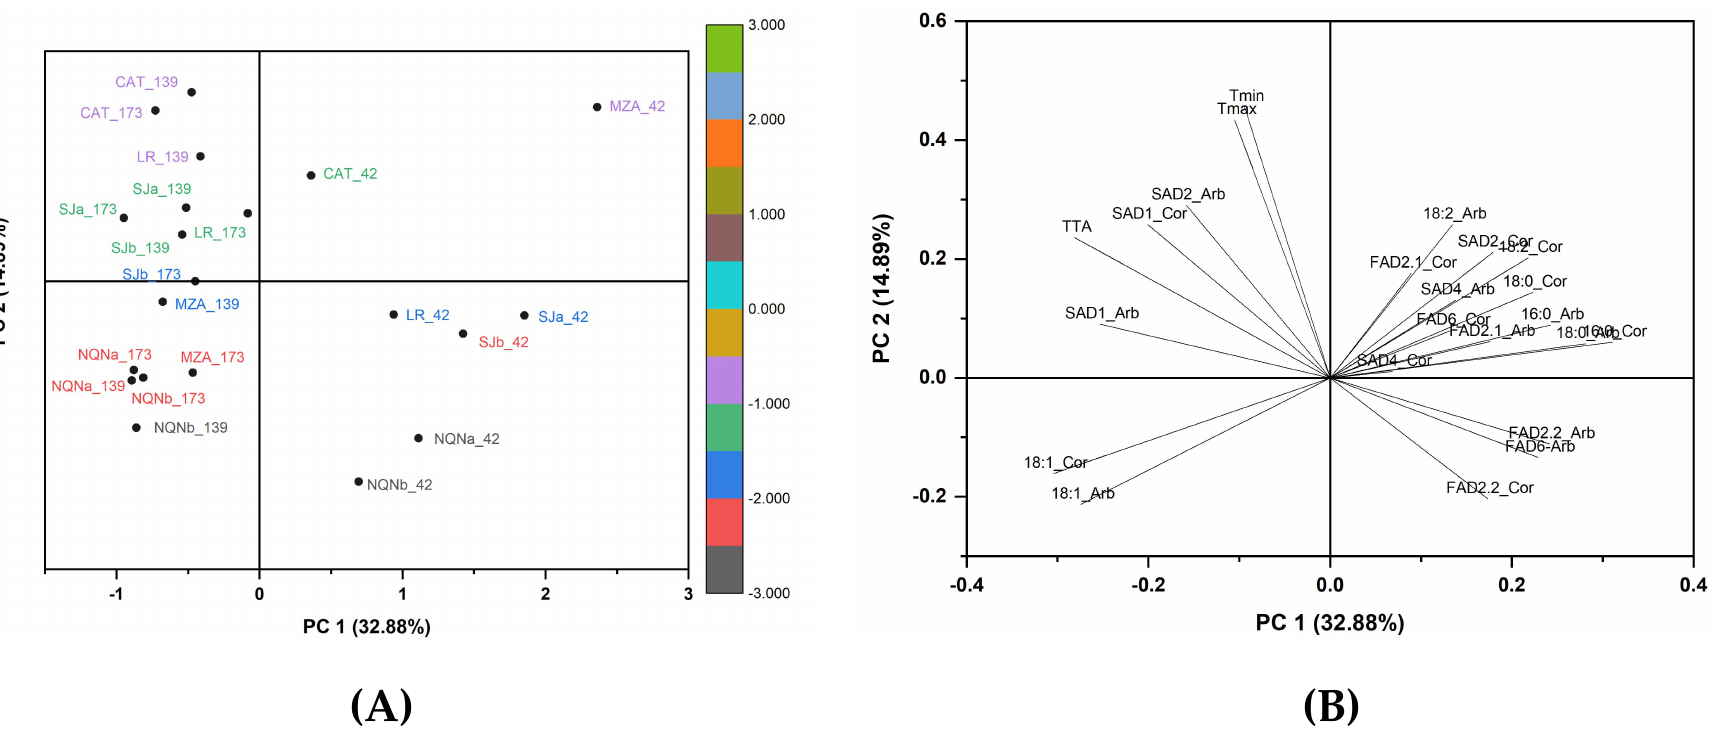
Figure 5. ( A ) Score plot of principal components 1 and 2 for the seven growing environments analyzed in cvs. Arbequina and Coratina; ( B ) loading plot for chemical, molecular and thermal regimes considered in both olive cultivars.